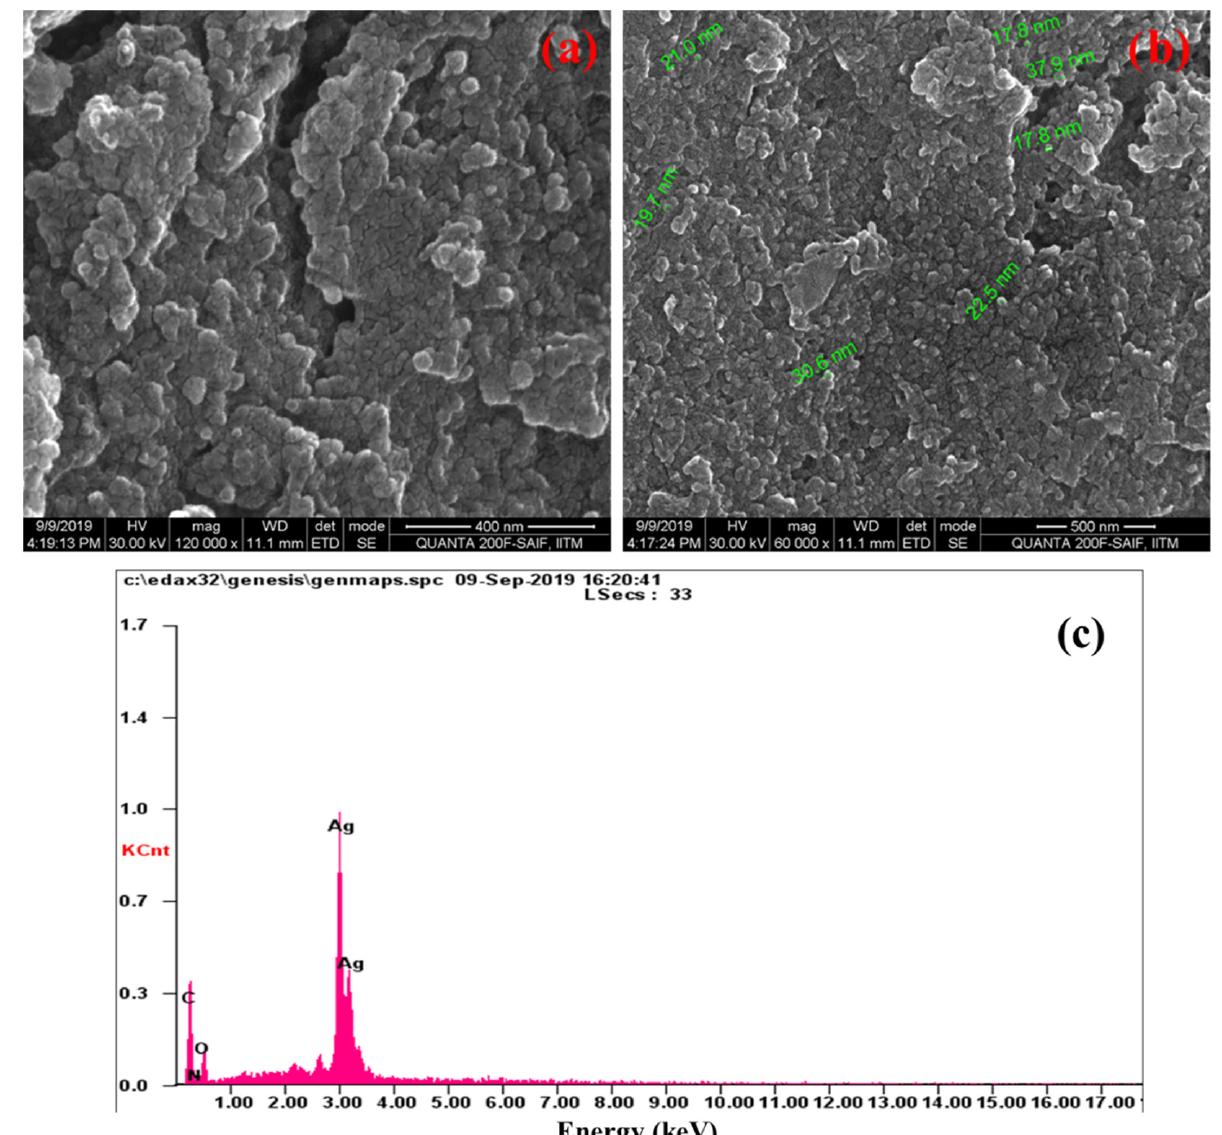
Figure 3. Morphology and elemental composition of green synthesized Ag NPs: ( a , b ) HRSEM images, and ( c ) EDX spectrum.